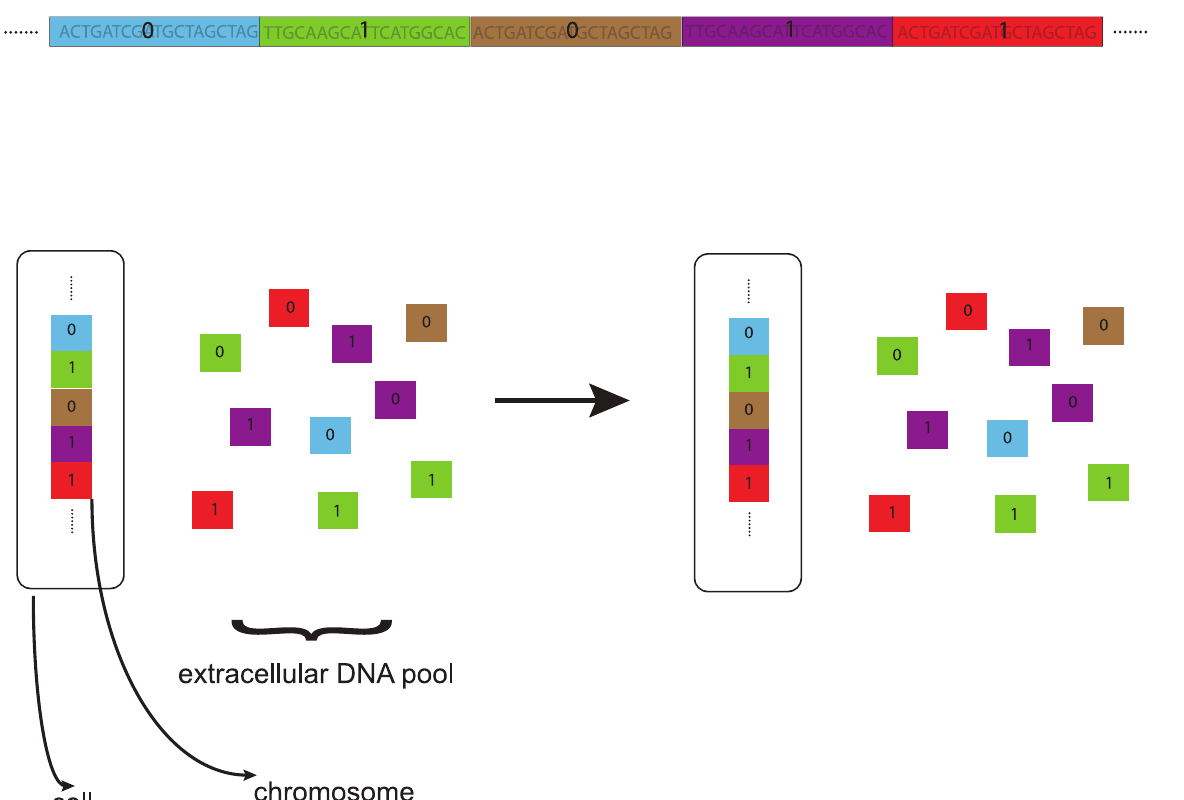
Figure 1. Genome and recombination model. Each genome contains l ( ~ 100 ) loci, each of which represents * 10 4 nucleotides and contributes independently to fitness. We assume that two families of alleles are segregating at each locus: more fit (labeled by ‘‘one’’) and less fit (labeled by ‘‘zero’’). Upon recombination (HGR), the acceptor allele is replaced by a homologous (same color) donor allele drawn randomly from the extracellular DNA pool. The allele frequencies in the extracellular pool are assumed to be identical to those among the population of living cells. Thus, HGR is not directly favored. The genetic change is non-reciprocal: the acceptor allele is presumed degraded and not placed in the extracellular pool. For simplicity, we do not represent loci that enable HGR. In figure S1 and text S1, we briefly consider an extracellular pool loaded with excess deleterious mutations.